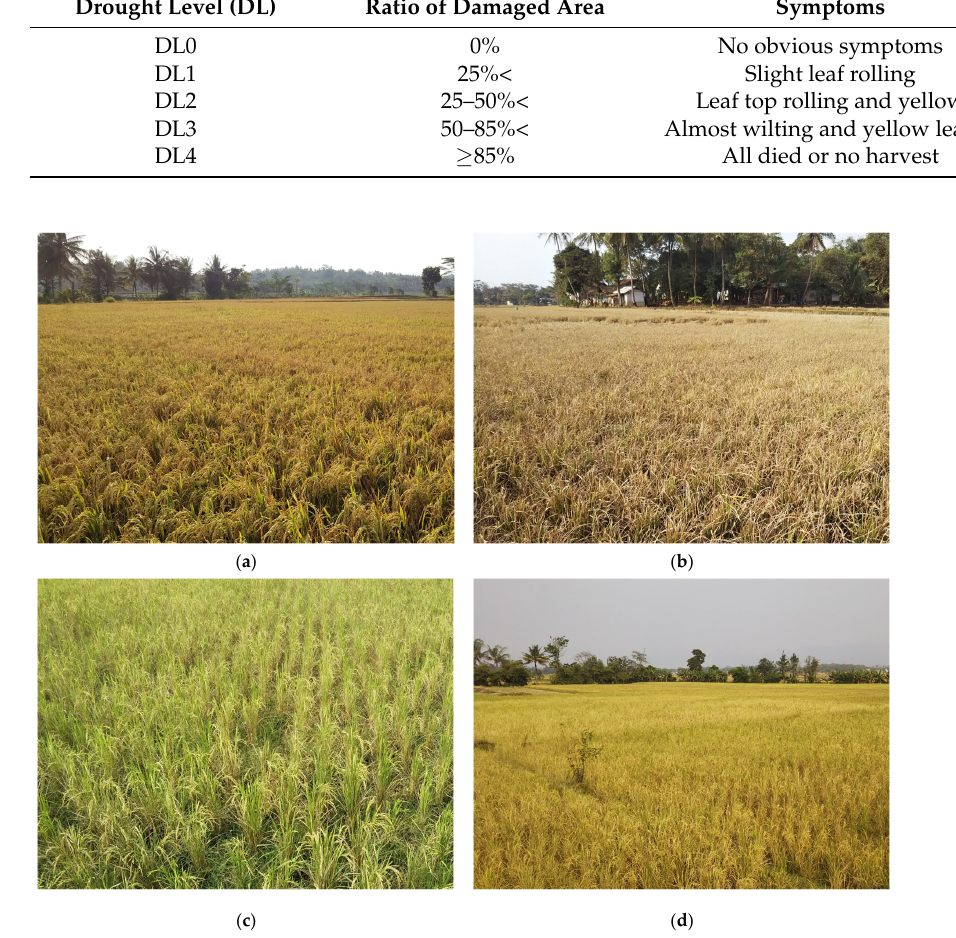
Figure 2. Example pictures of assessed fields by a pest observer: ( a ) paddy fields assessed as DL2 in Kertajaya; ( b ) assessed as DL4 in Kertajaya; ( c ) assessed as DL2 in Karangwangi; ( d ) assessed as DL3 in Karangwangi. Table 3. Details of information on the third survey in 2021.